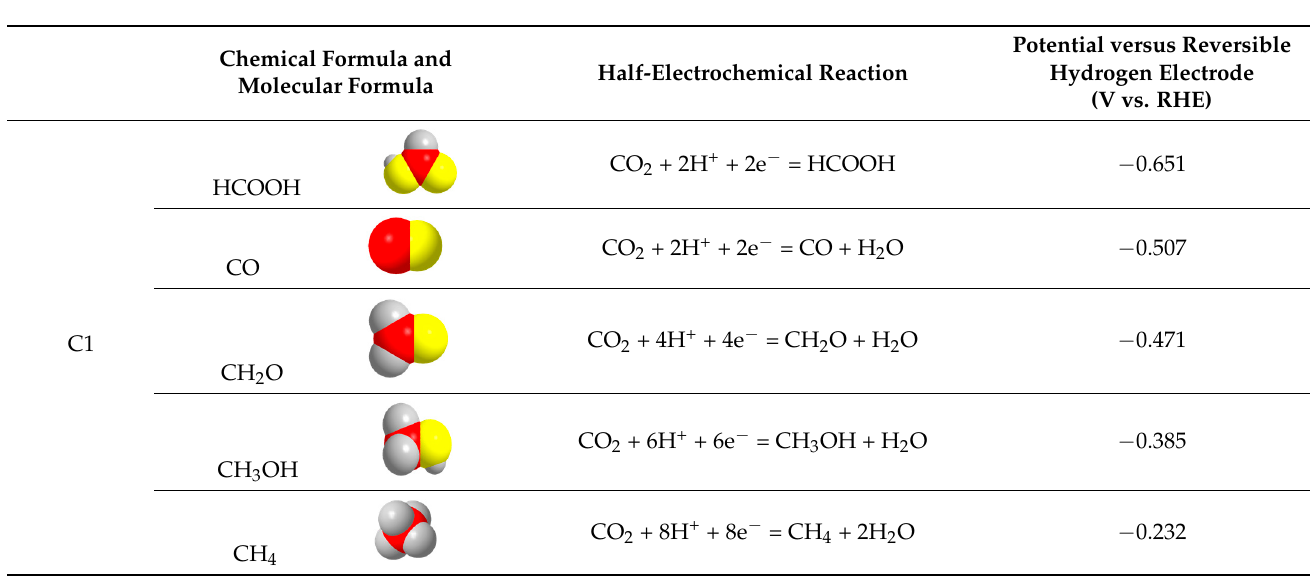
Table 1. Electrode potentials of selected CO 2 reduction reaction in a 0.1 M solution of KHCO 3 at 1.0 atm and 25 °C.